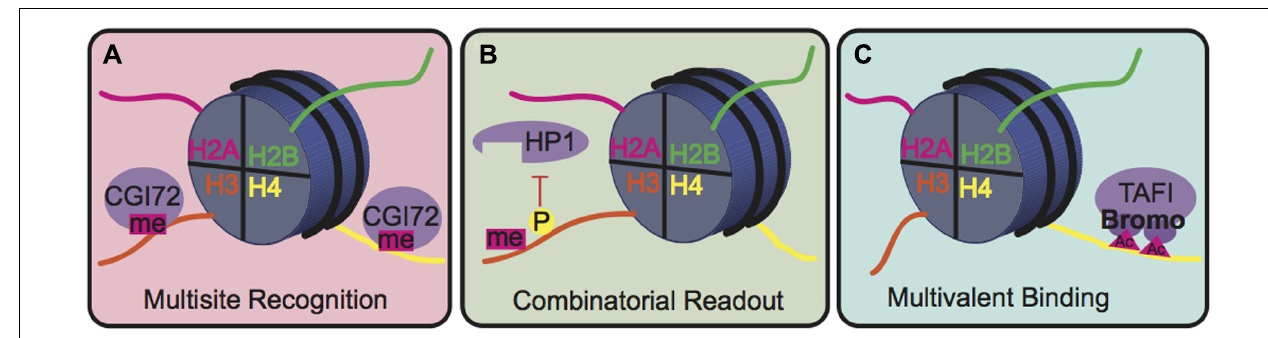
FIGURE 5 | Binding modes for histone readers. (A) In multisite recognition, a reader can recognize the same mark in several locations, either on the same tail or on different tails. (B) Combinatorial readout occurs when a reader